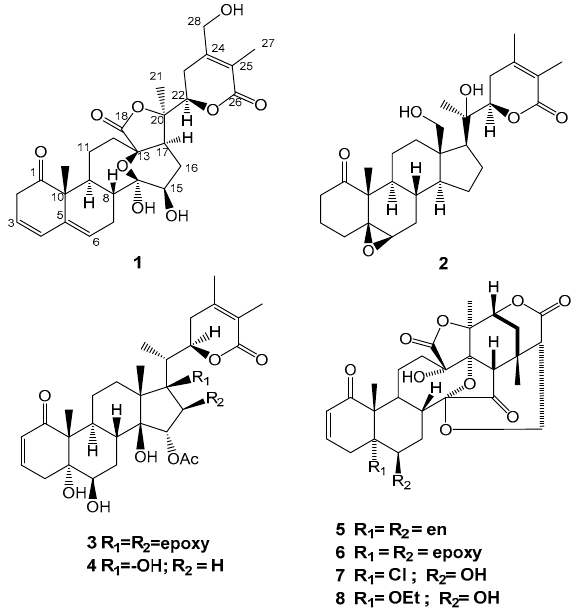
Figure 1. Structures of compounds 1 – 8 from P. angulata L.